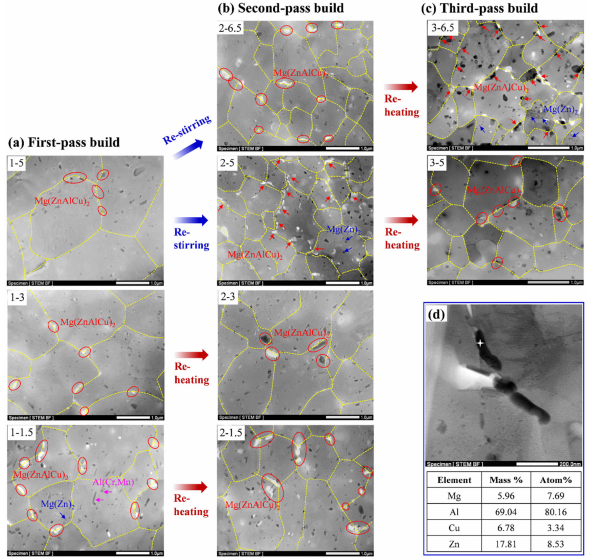
Figure 8. Scanning transmission electron microscopy (STEM) images of the ( a ) first-, ( b ) second-, and ( c ) third-pass builds; and ( d ) STEM–EDS result of the phase along the grain boundary. The specified positions of the STEM images are shown in Figure 3a–c, marked with red